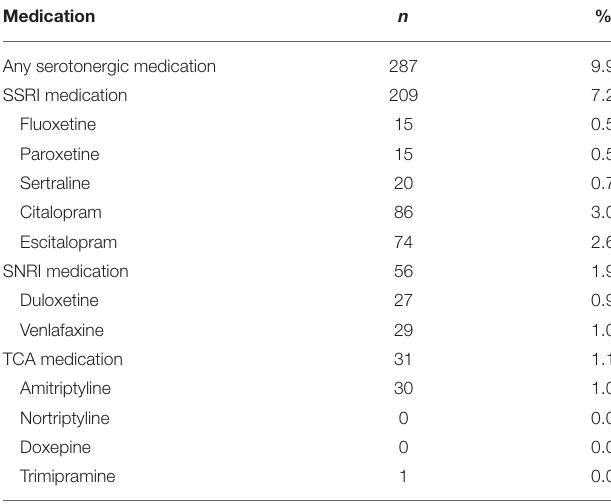
TABLE 3 | Antidepressant medication use in the